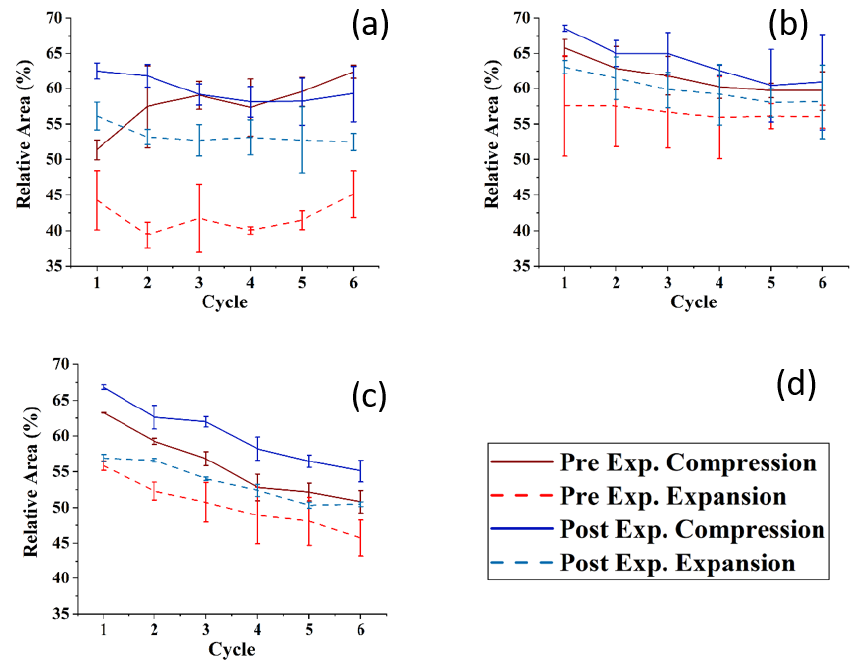
Figure 7. The relative area at 10 mNm -1 of the compression ( d , dark red line: pre-ozone exposure, dark blue line: post-ozone exposure) and expansion ( d , dashed light red: pre-ozone exposure, dashed light blue: post-ozone exposure) as a function of the cycle number for ( a ) CO:PC 90:10 (binary mixture); ( b ) CO:GT:PC 40:40:20 (ternary mixture); and ( c ) CO:GT:FFA:PC 40:25:15:20 (quaternary mixture) on PBS at 22 °C. The data points and error bars represent the mean and standard deviation of at least three independent cycling experiments.